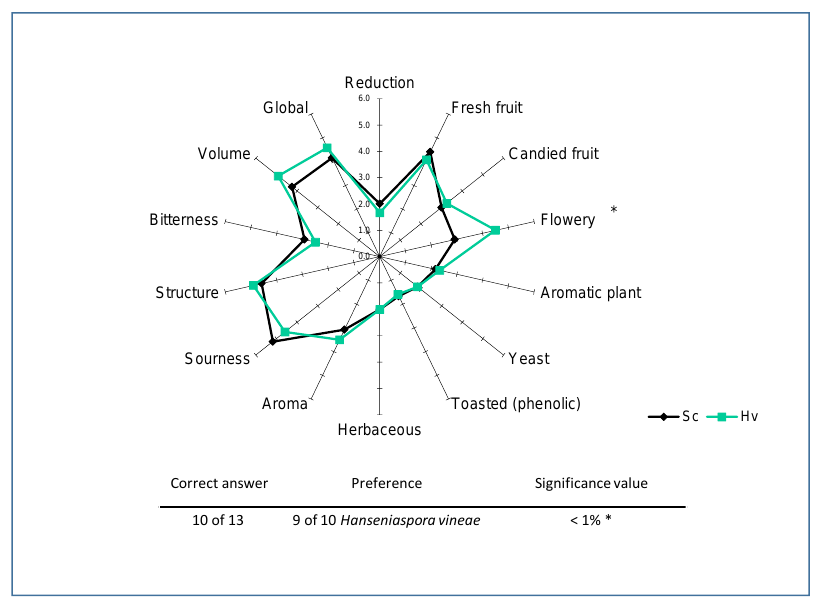
Figure 12. Results of the triangle (table) and descriptive (graphic) test of Macabeo wine fermented with Hanseniaspora vineae and Saccharomyces cerevisiae . Significant value * is indicated for flowery.